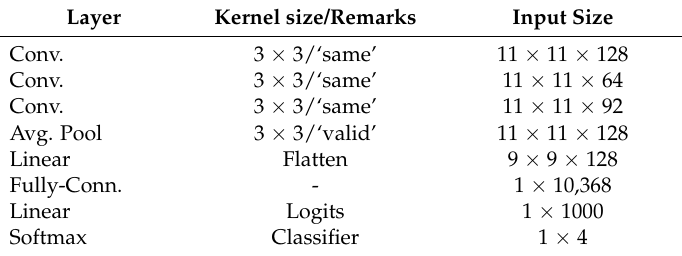
Table 2. Schematic of the proposed two-dimensional convolutional neural network (2D-CNN) architecture. The input size is given in each row. The output size is the input size of the next row. All convolutions were performed with sigmoid activation and 40%